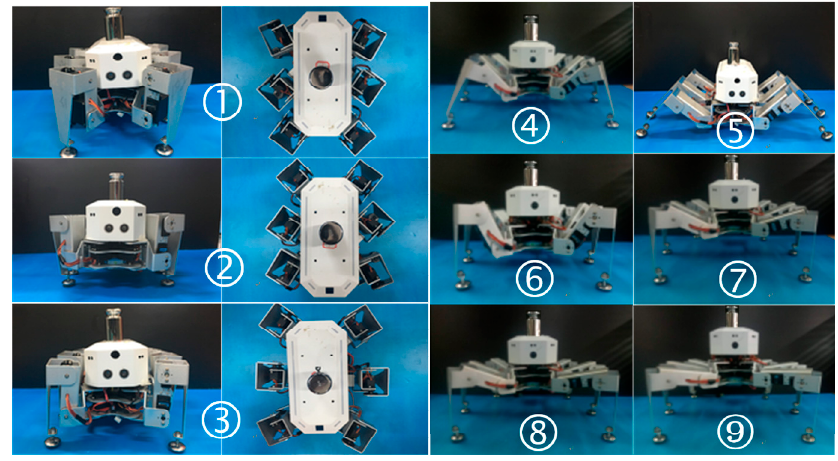
Figure 13. Static postures of robot when only considering the energy consumption target. Table 6. Data of Figure 14. Robot Standing Average System Posture Number